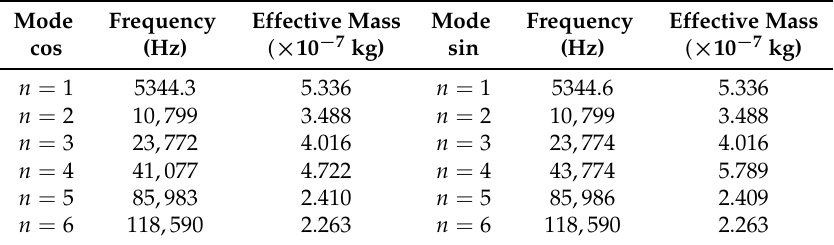
Table 2. Modal frequencies and corresponding effective masses of the MRR.